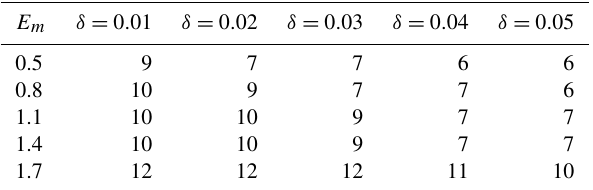
Table 9. The LBMPT estimated by the ADJ-CNOP method.